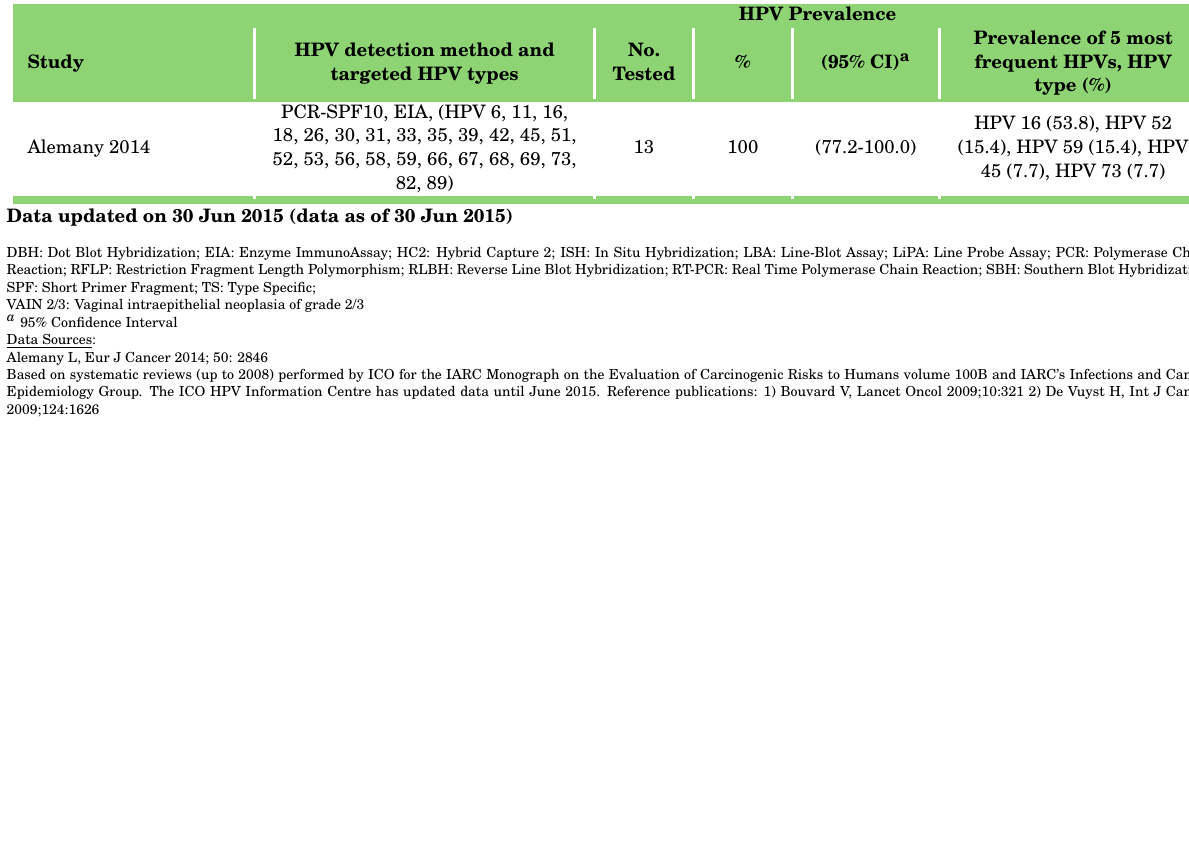
Table 30: Studies on HPV prevalence among VaIN 2/3 cases in India